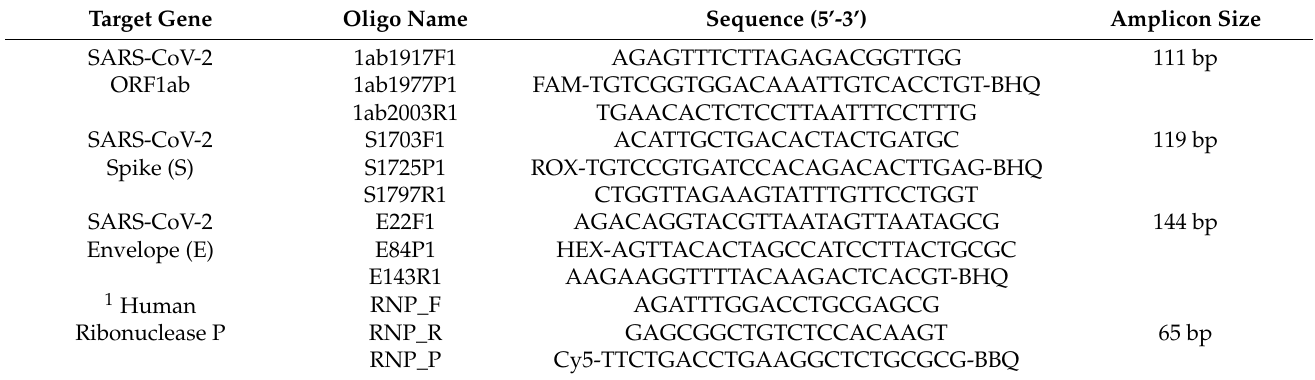
Table 1. Design of the one-step quadruplex qRT-PCR assays for the detection of three SARS-CoV-2 genes and internal human control